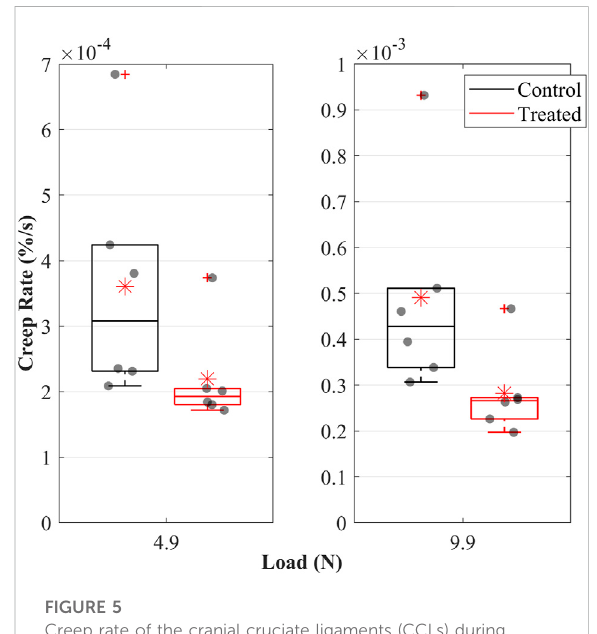
FIGURE 5 Creep rate of the cranial cruciate ligaments (CCLs) during loading at4.9 N and 9.9 Nin thecontrol (black lines) group, where proteoglycans were not depleted, and in the treated (red lines) group, where proteoglycans were depleted. The box plot shows individual specimen values (grey dots) and means (red asterisk). The outliers are indicated with a red plus